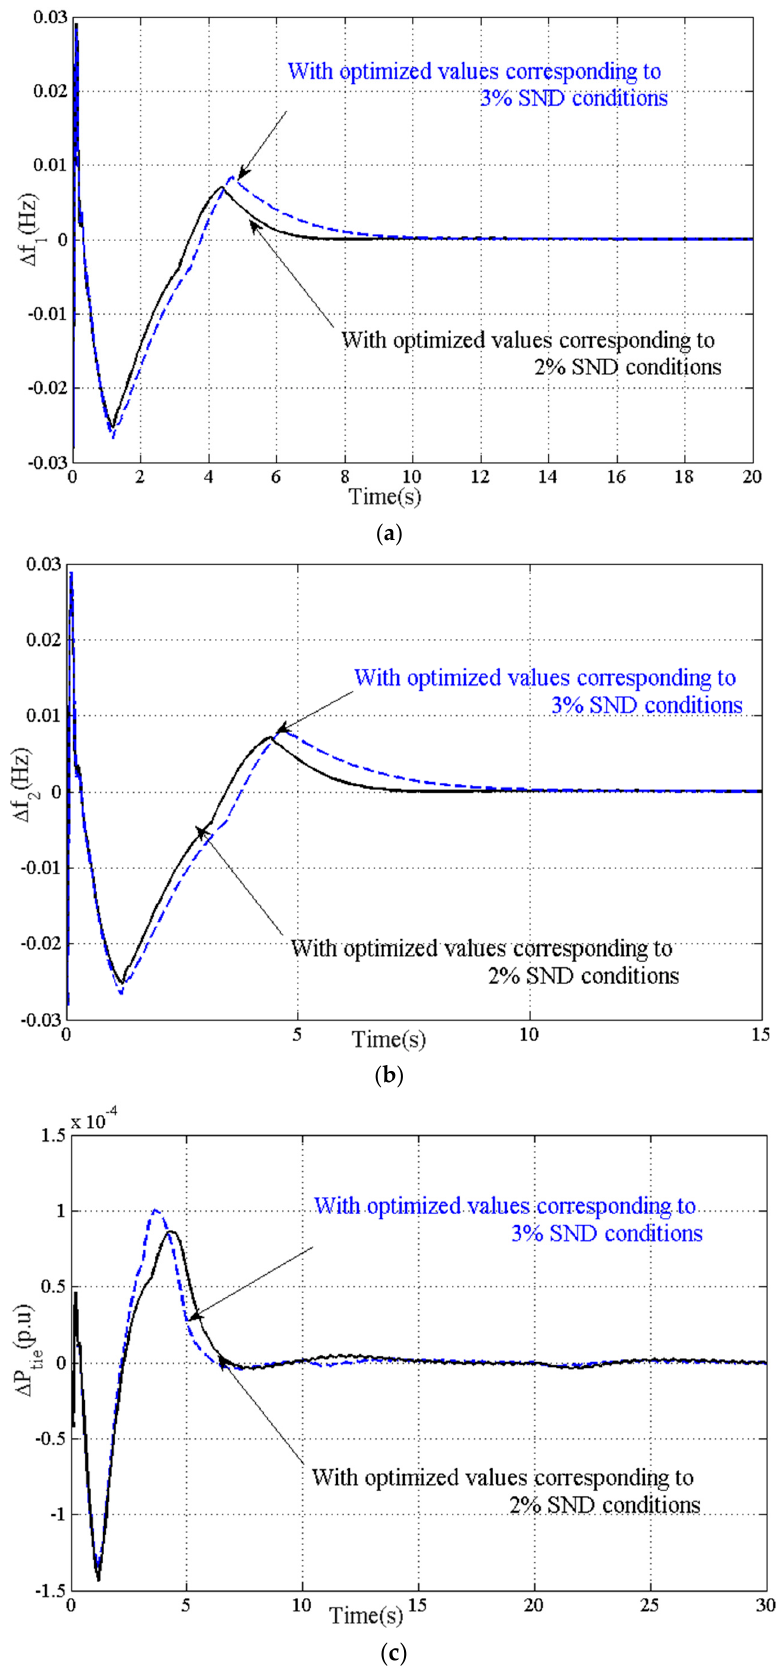
Figure 14. Insensitiveness of PID controller at 3% SND. ( a ) ∆ f 1 ; ( b ) ∆ f 2 ; and ( c ) ∆ P tie .